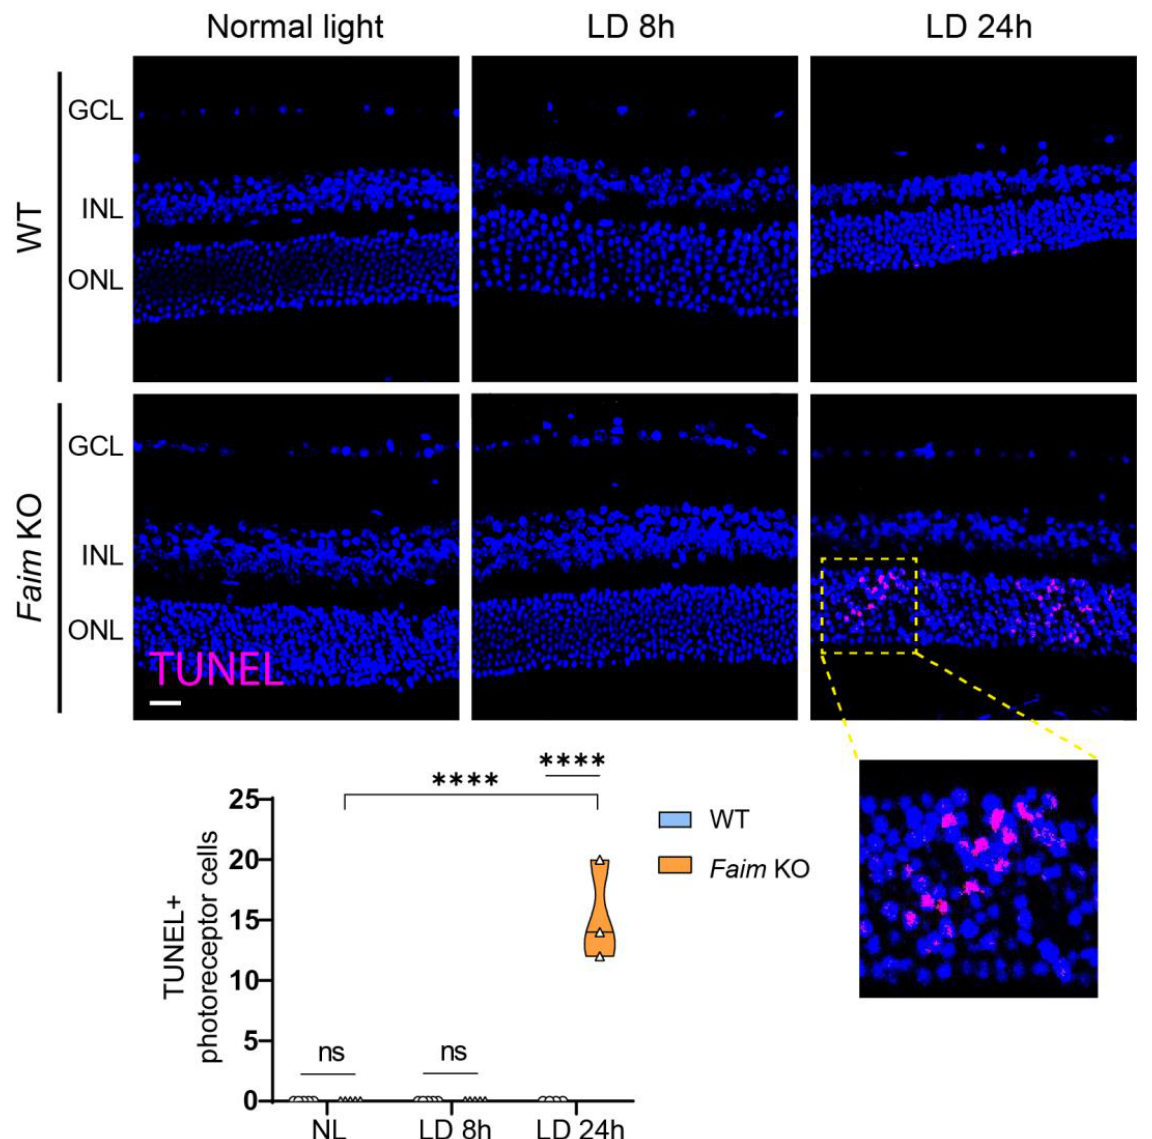
Figure 10. Light-induced retinal cell death in Faim KO mice after 24 h of light exposure at 8000 lux. Representative images of 4 µ m paraffin sections of retinas taken from three-month-old mice exposed to normal light and to light damage for 8 h (LD 8 h) or 24 h (LD 24 h) and TUNEL assay was performed (magenta). Nuclei were stained with Hoechst (blue). Total number of TUNEL+ cells per section were counted. Each violin plot extends from the min to max values and the median is represented by a thick dashed line ( n = 4–6 mice/group). Statistical analysis was performed using Two-way ANOVA and Sidak’s post-hoc test. **** p < 0.001. GCL: ganglion cell layer; INL: inner nuclear layer; ONL: outer nuclear layer. Scale bar: 20 μm.